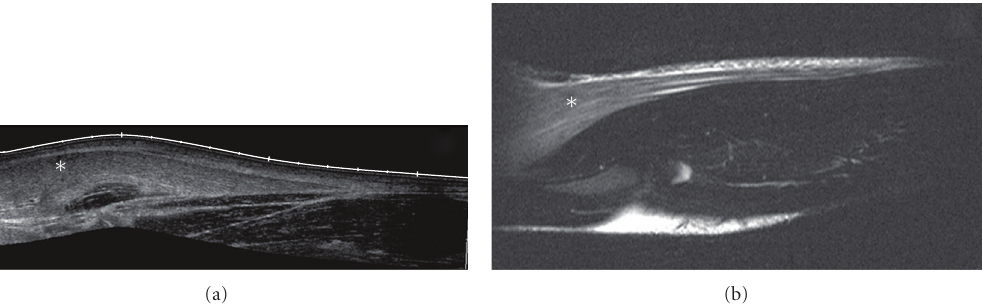
Figure 1: Ultrasound compound image (a) and corresponding sagittal MRI T2w TSE (b) of the right-hand elbow and forearm showing markedly increased echogenicity and corresponding signal increase of the brachioradial muscle (marked as ∗ ).